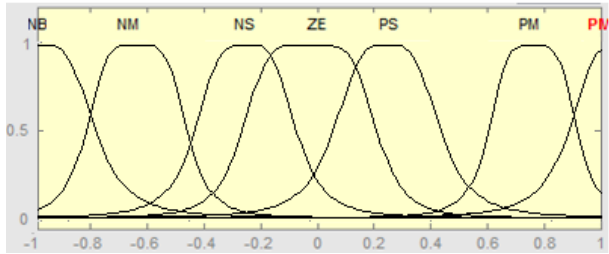
Figure 9. The membership functions of Qe(t) after training